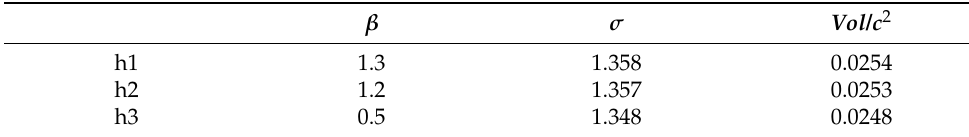
Figure 6. Present method for NACA16 – 006 at a = 6deg for N = 42 DOFS. ( a ) Initial guesses h1, h2, and h3 for the cavity shape ( b ) Cost functional evolution for each initial guess as to the optimization cycles progress.